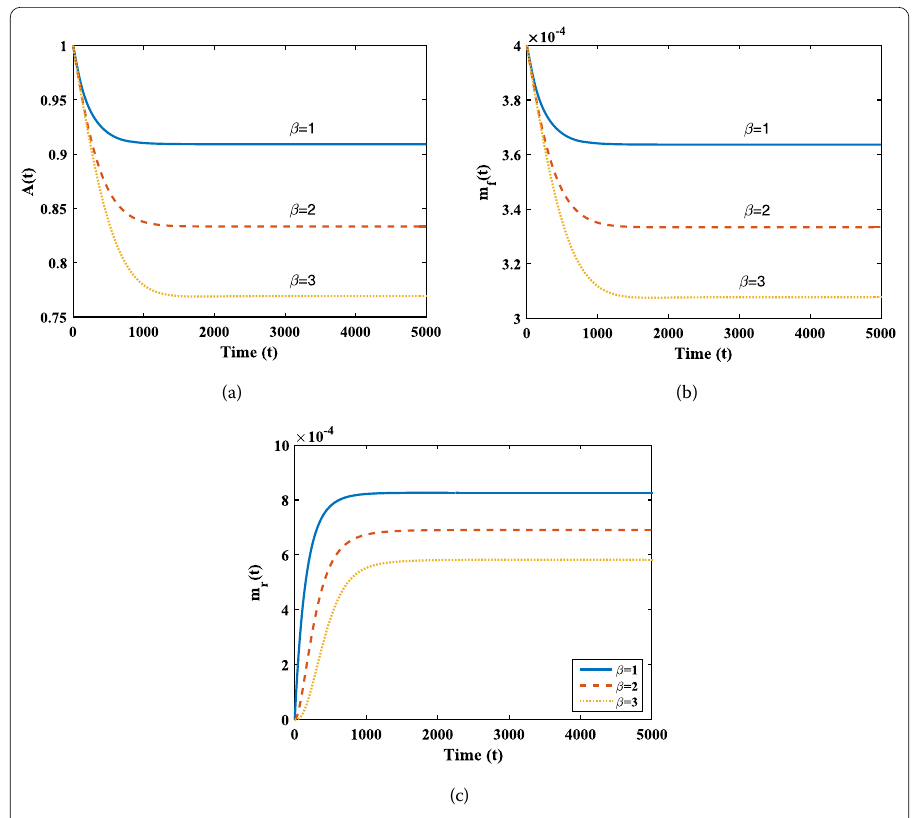
Figure 2 Time-dependent reliability indices for gamma distributed repair time. ( a ) Availability for different β ; ( b ) Failure frequency for different β ; ( c ) Renewal frequency for different